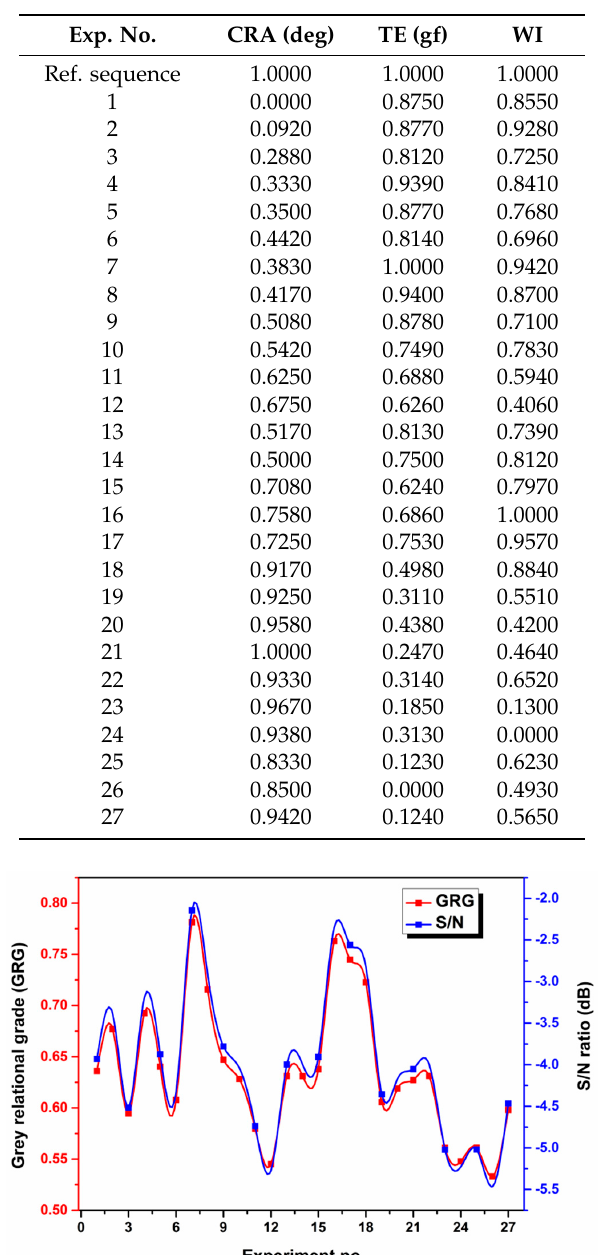
Figure 4. GRG and its S/N ratio.